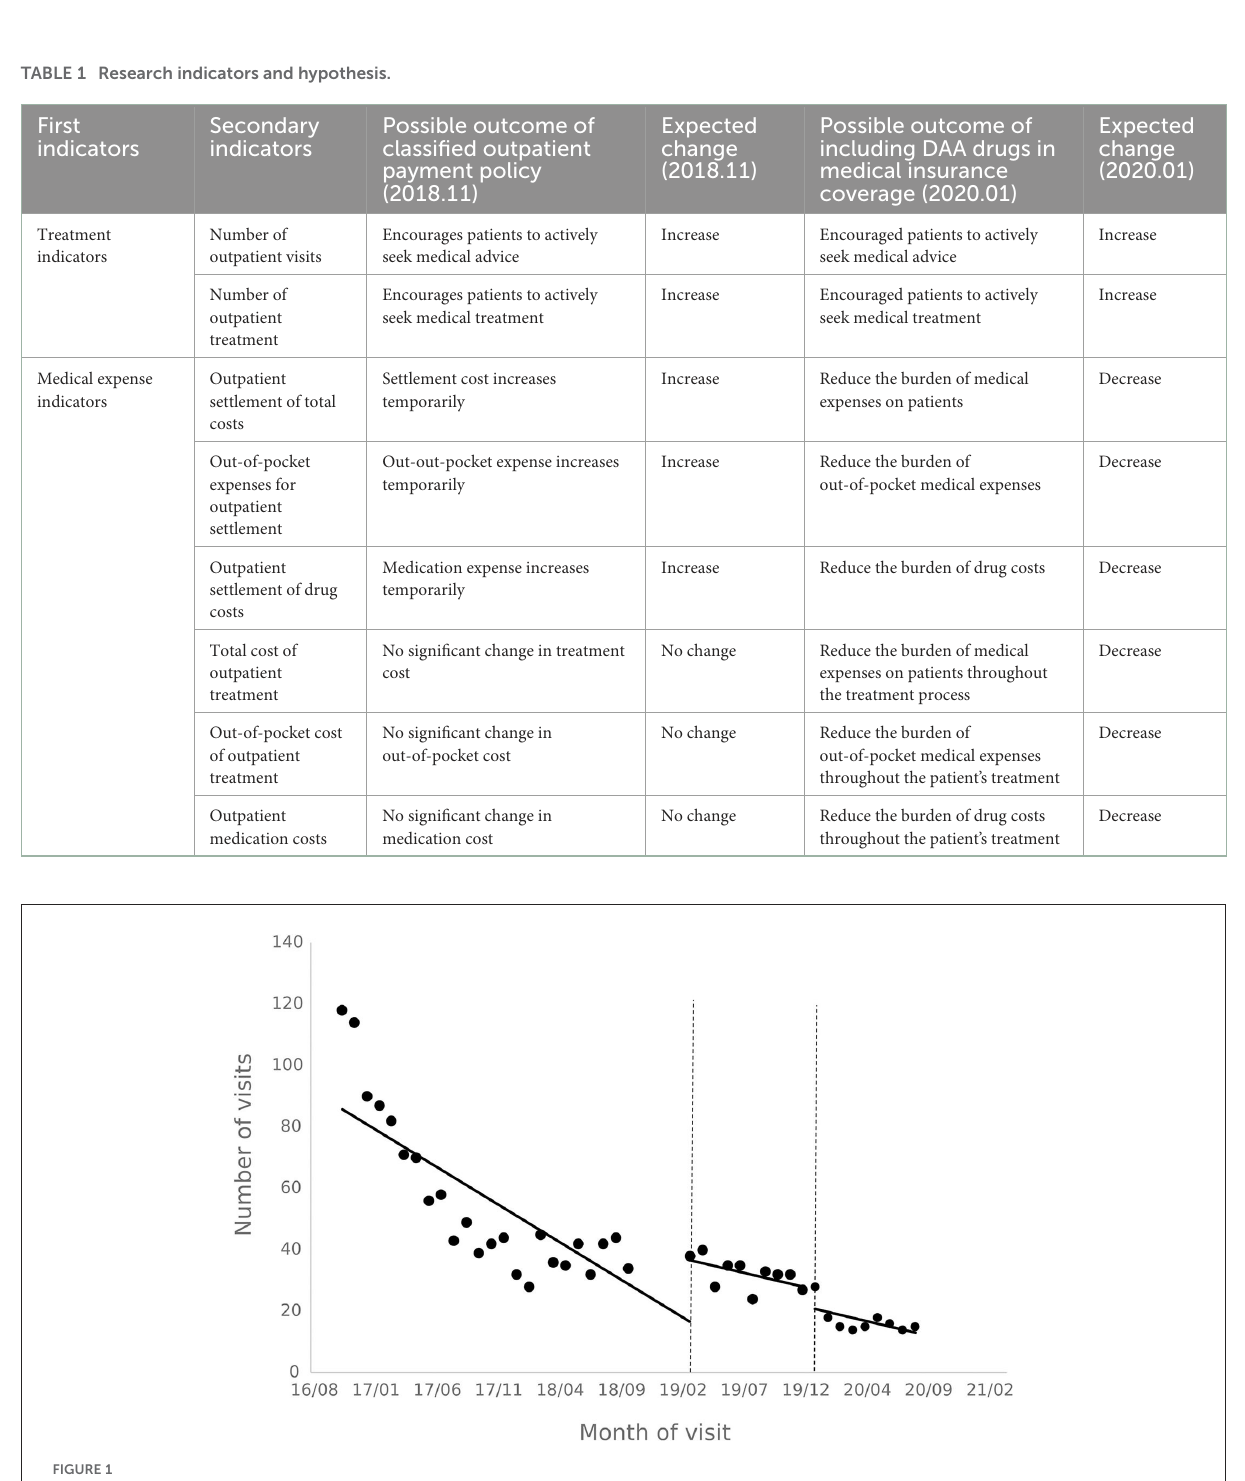
change in the medical burden of hepatitis C patients remain to be